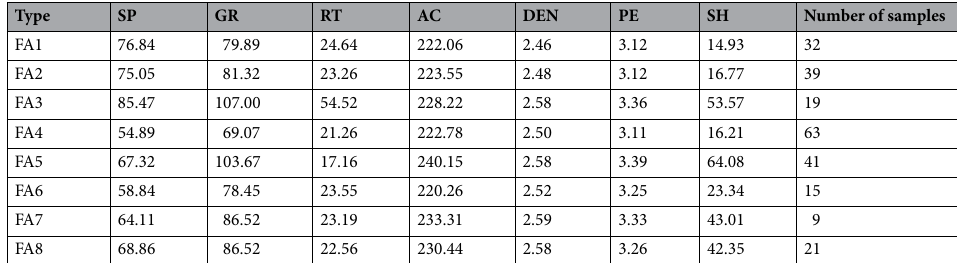
Table 6. Logging curve parameter statistics of each architectural element (sample number: 239). The above data are the thickness-weighted average values of the logging parameters of the main target horizon. SP is the spontaneous potential logging curve, GR is the natural gamma logging curve, RT is the resistivity logging curve, AC is the acoustic transit time logging curve, DEN is the density logging curve, PE is the photoelectric cross-section index; SH is the shale content.